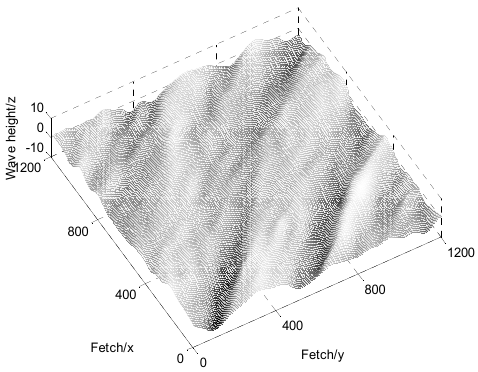
Figure 2. Simulation of 2-D sea surface by Monte Carlo method with wind speed 16 km/h, fetch 12 km and wind direction 320°.